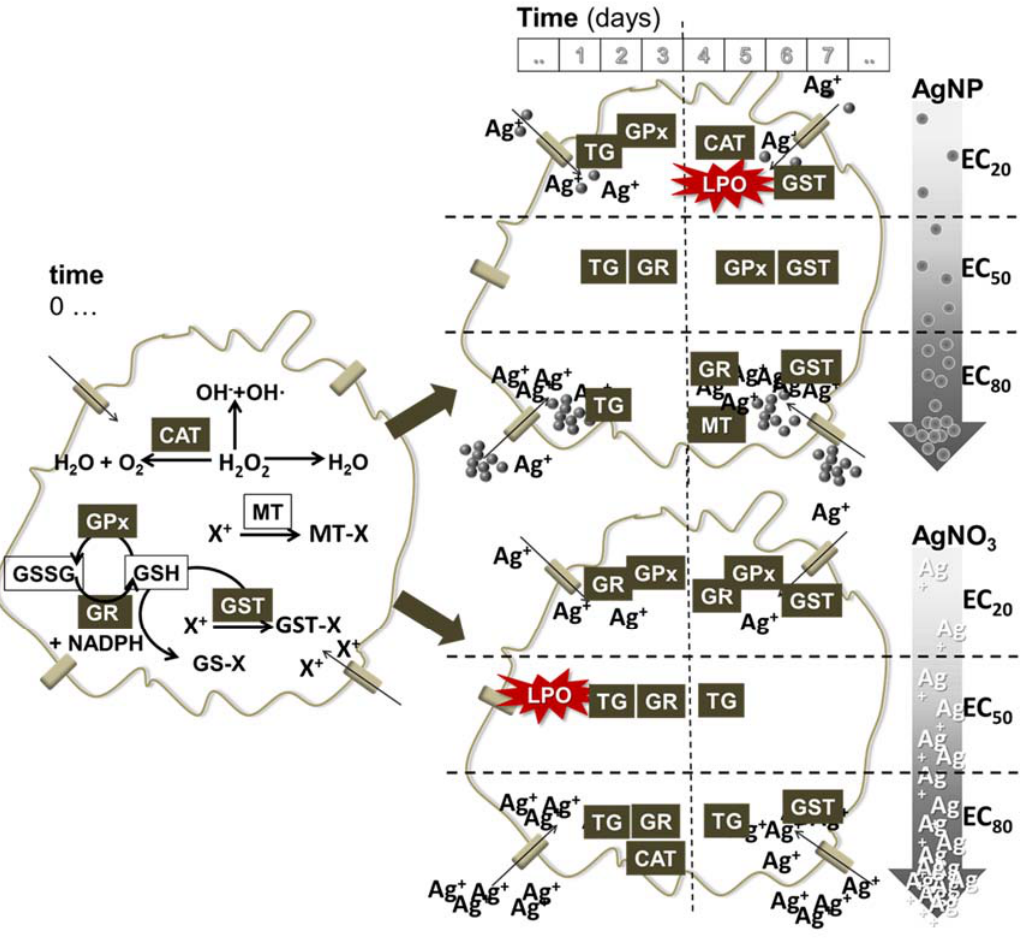
Figure 3. Schematic representation of the redox events in the cell when exposed to AgNP and AgNO 3 (variation in concentration is signalled in the arrows from low to high (EC20–50–80), top to bottom respectively) and along various time periods (0–3–7 days). Cell at time 0 (left) indicates the general set of existing reactions that occur involving the measured markers in the present study. CAT: catalase, GPx: glutathione peroxidase, GST: glutathione S-transferase, GR: glutathione reductase, TG: total glutathione, MT: metallothionein, LPO: lipid